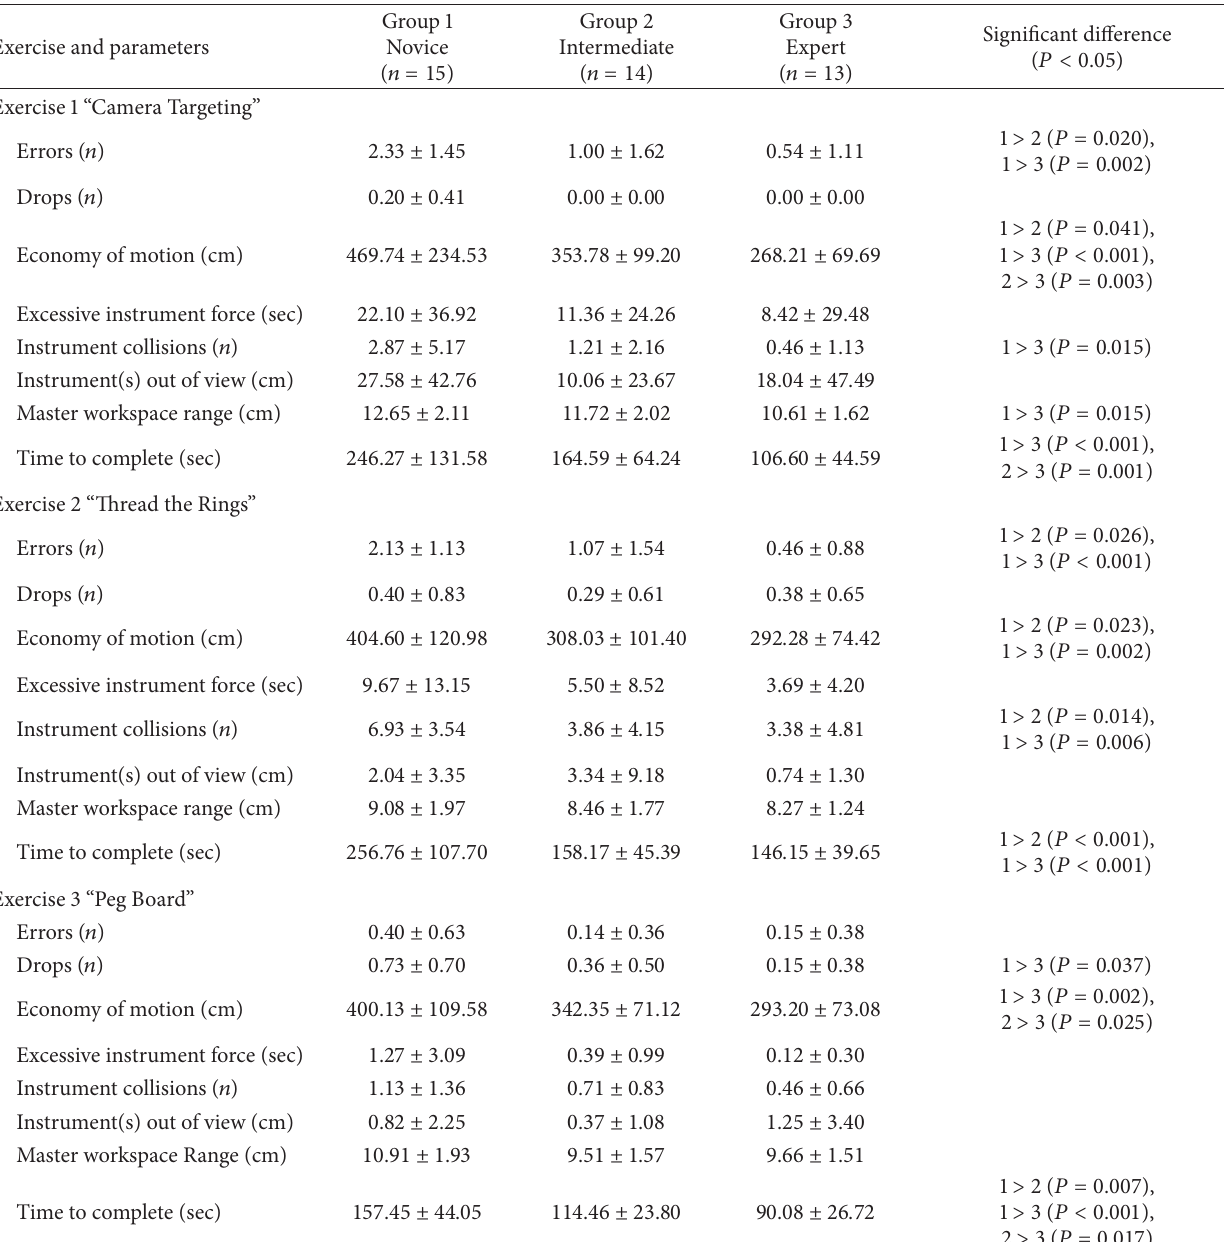
Table 5: Construct